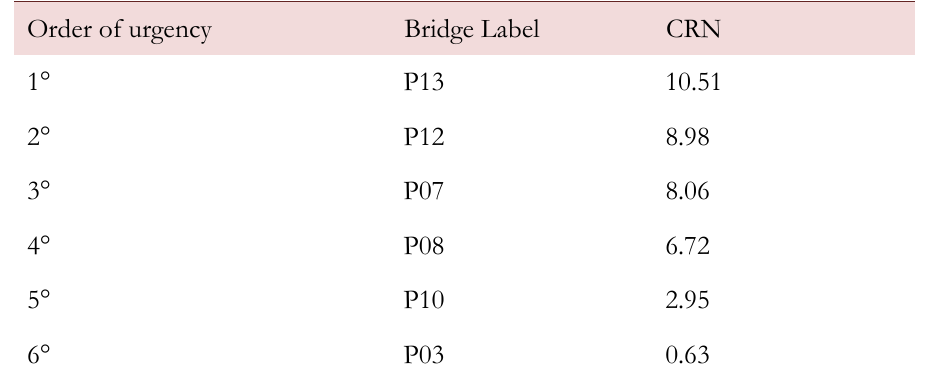
Table 10: Intervention order within the infrastructure